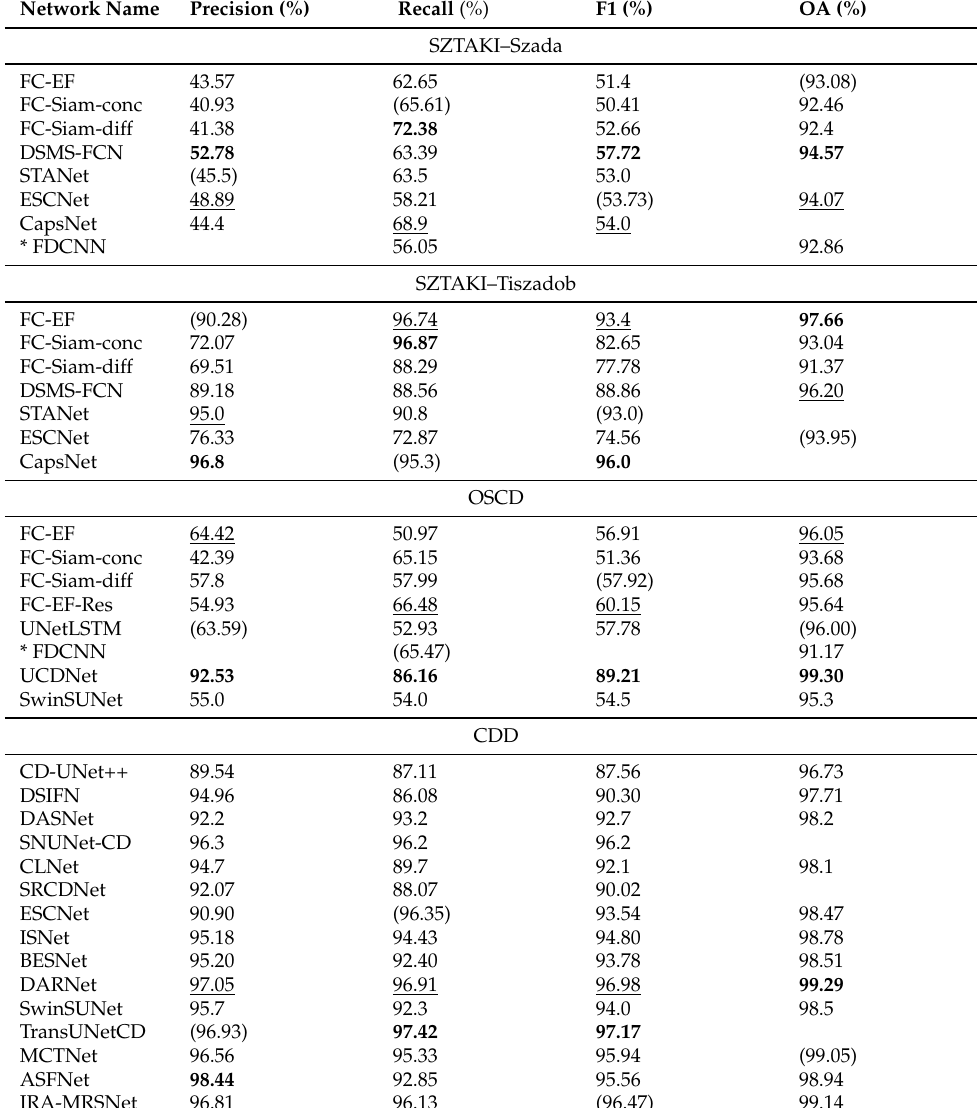
Table 4. Performance values of a selection of models grouped by the dataset used for evaluation. Semi-supervised models are denoted with *. The best results for each dataset are shown in bold , the second best are underlined, and the (third best) results are enclosed in parentheses (). For some semi-supervised models, the percentage of the dataset used for training is also